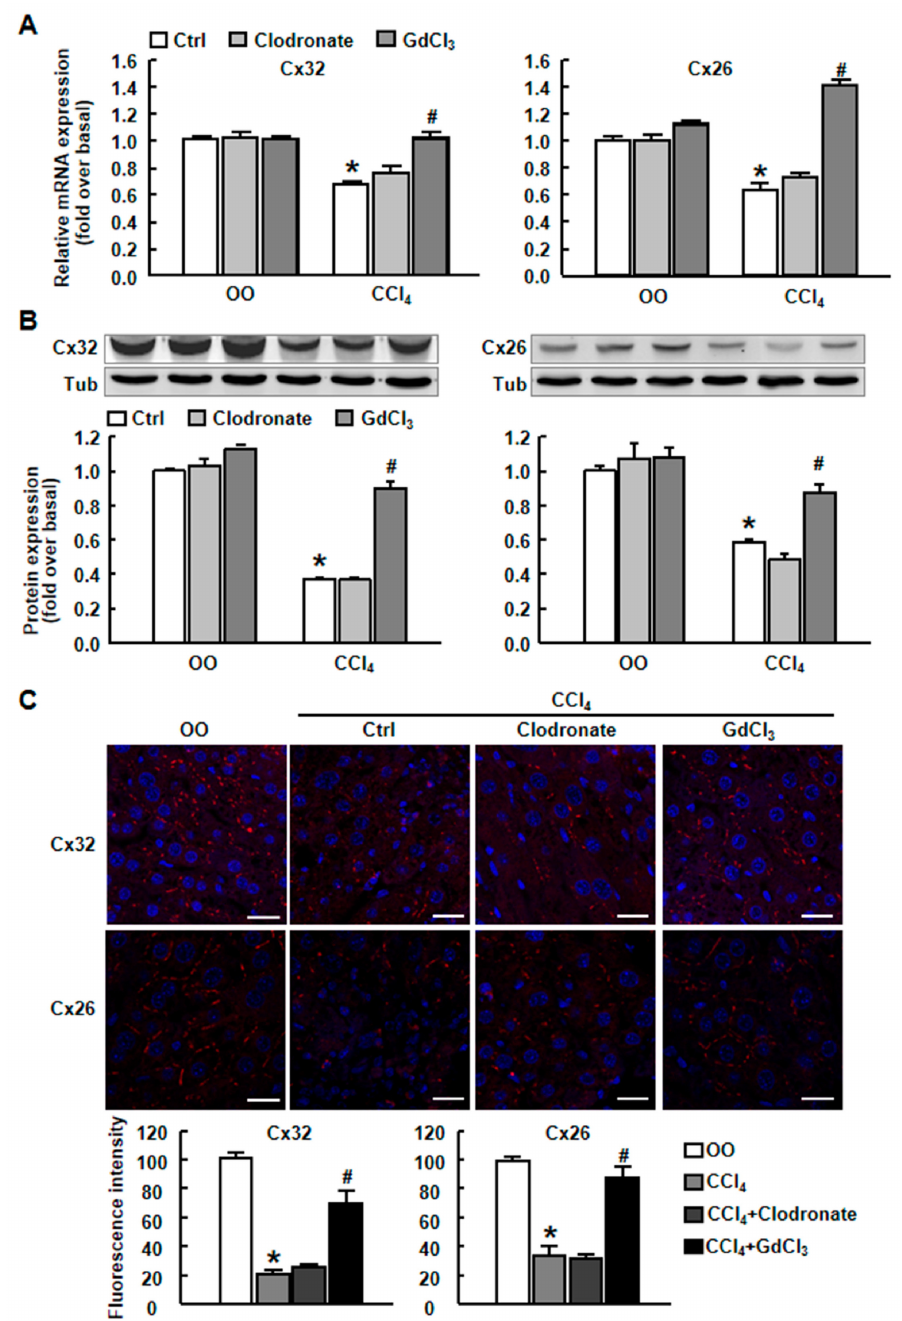
Figure 5. The expression of Cx32 and Cx26 in CCl 4 -treated liver tissue with or without clodronate administration. Clodronate liposome (10 L / g B.W.) injection was performed once 72 h before CCl 4 treatment to delete Kup ff er cells. The qRT-PCR, western blot analysis and immunofluorescence staining for the expression of Cx32 and Cx26 were performed. ( A ) Cx32 and Cx26 mRNA expression in injured liver. ( B ) Cx32 and Cx26 protein expression in injured liver. Typical autoradiograms are shown. Expression of tubulin was checked to correct for variations in protein loading and transfer. ( C ) Immunofluorescence staining for Cx32 and Cx26 in injured liver. Scale bars, 100 µ m. All results were confirmed in three independent experiments. Data are presented as the mean ± SEM, and were analyzed by ANOVA for analysis of variance. * p < 0.05 vs. Ctrl. # p < 0.05 vs. CCl 4 -treated mice